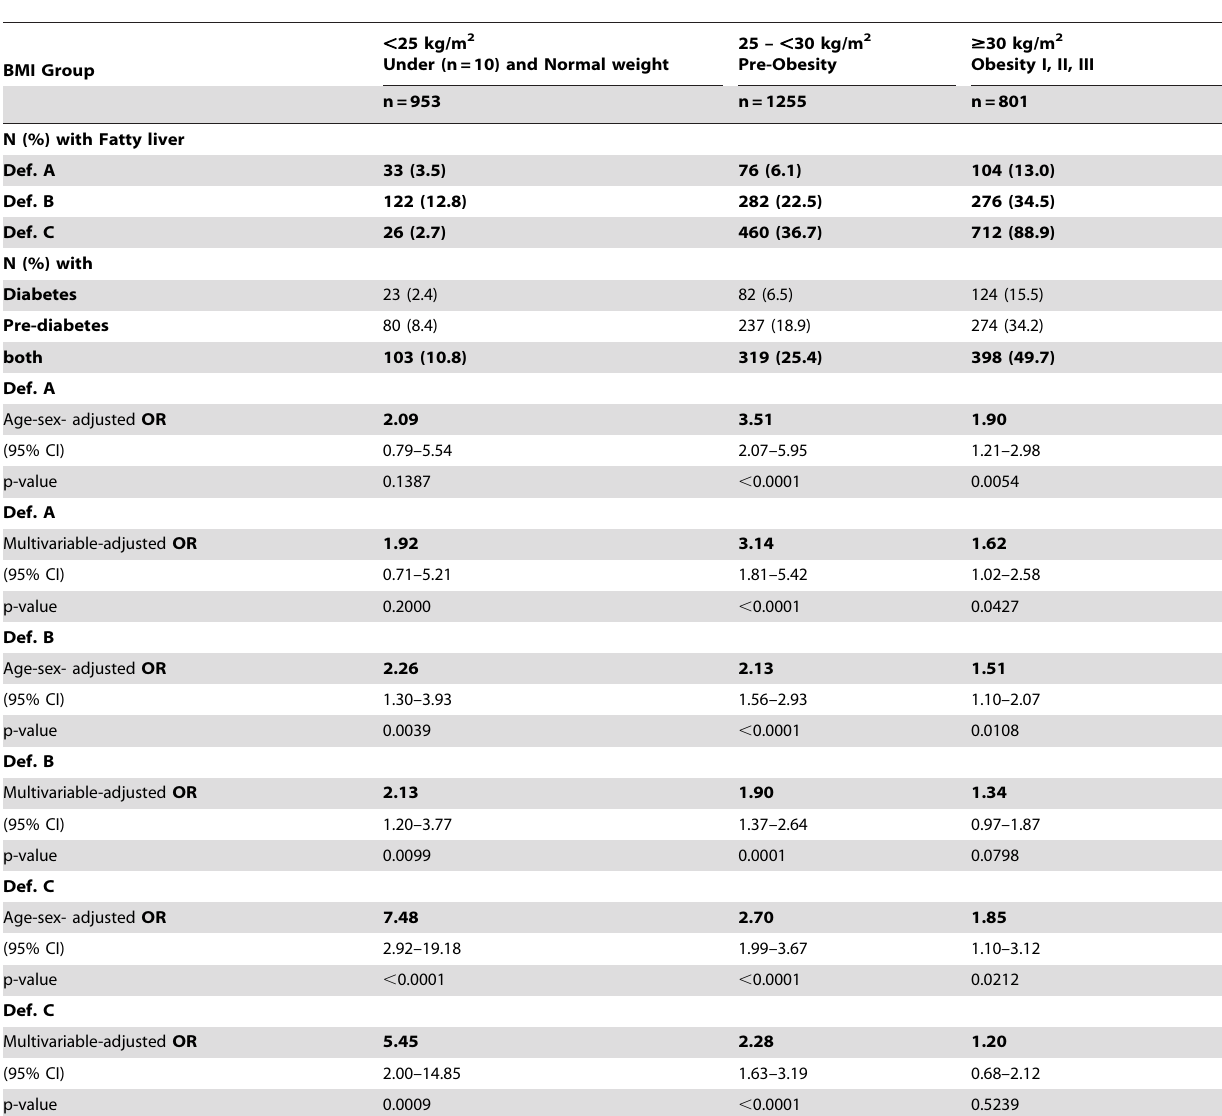
Table 4. Frequencies and association of fatty liver and glucose metabolism disturbance (pre-diabetes or diabetes) within BMI